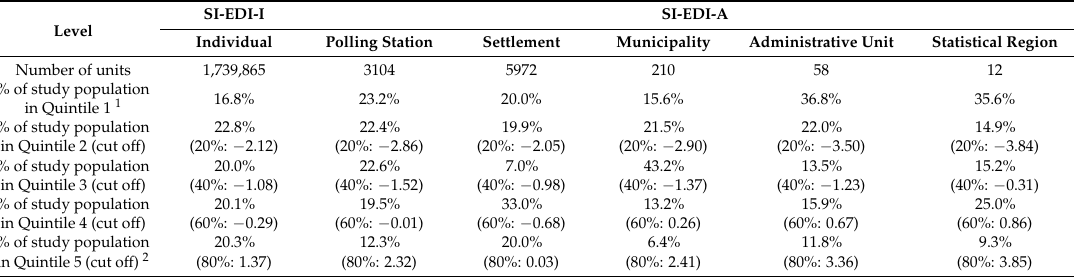
Table 1. The comparison of SI-EDI across different